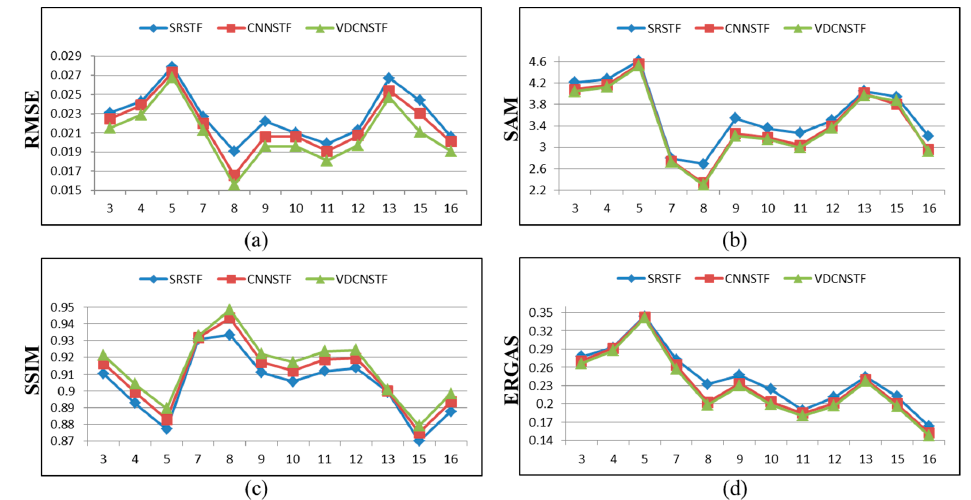
Figure 4. Quantitative results of 12 prediction dates at the CIA site: ( a ) RMSE; ( b ) SAM; ( c ) SSIM; ( d ) ERGAS.